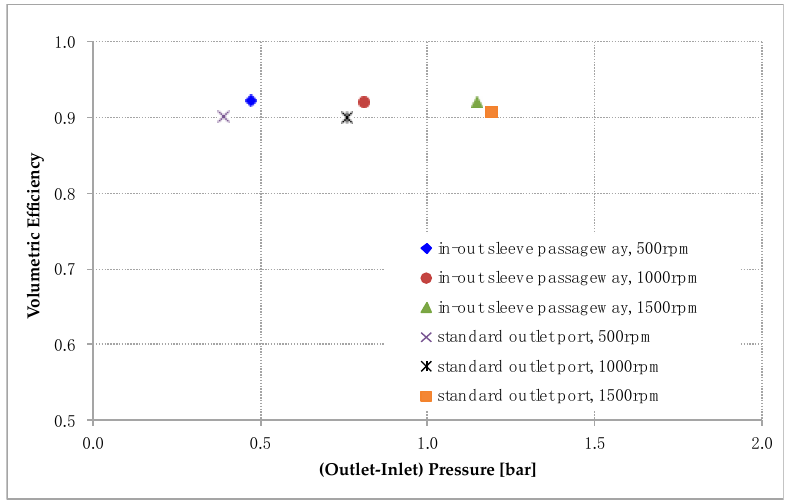
Figure 16. mTGp volumetric efficiency sintered inner gear performance comparison between ‘in-out sleeve passageway’ and standard outlet port configuration.